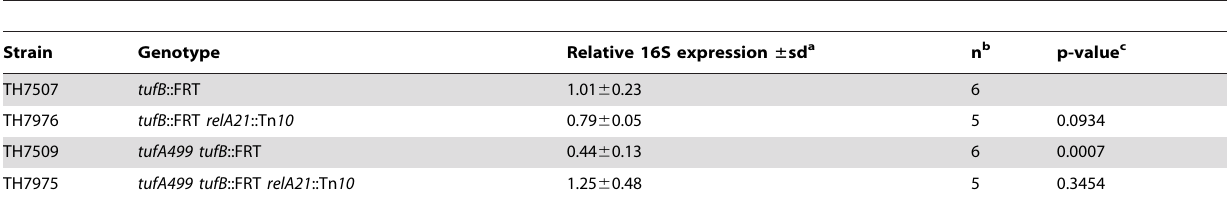
Table 4. The tufA499 mutation is associated with a low expression of 16S rRNA, which can be compensated for by inactivation of relA